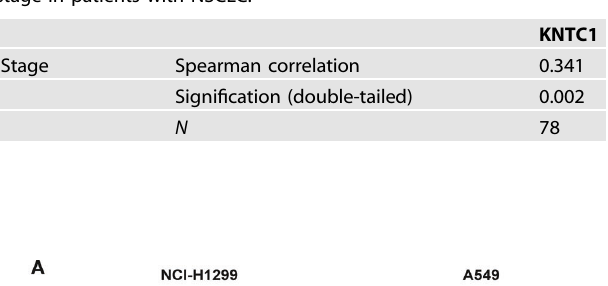
Table 3. Relationship between KNTC1 expression and pathological stage in patients with